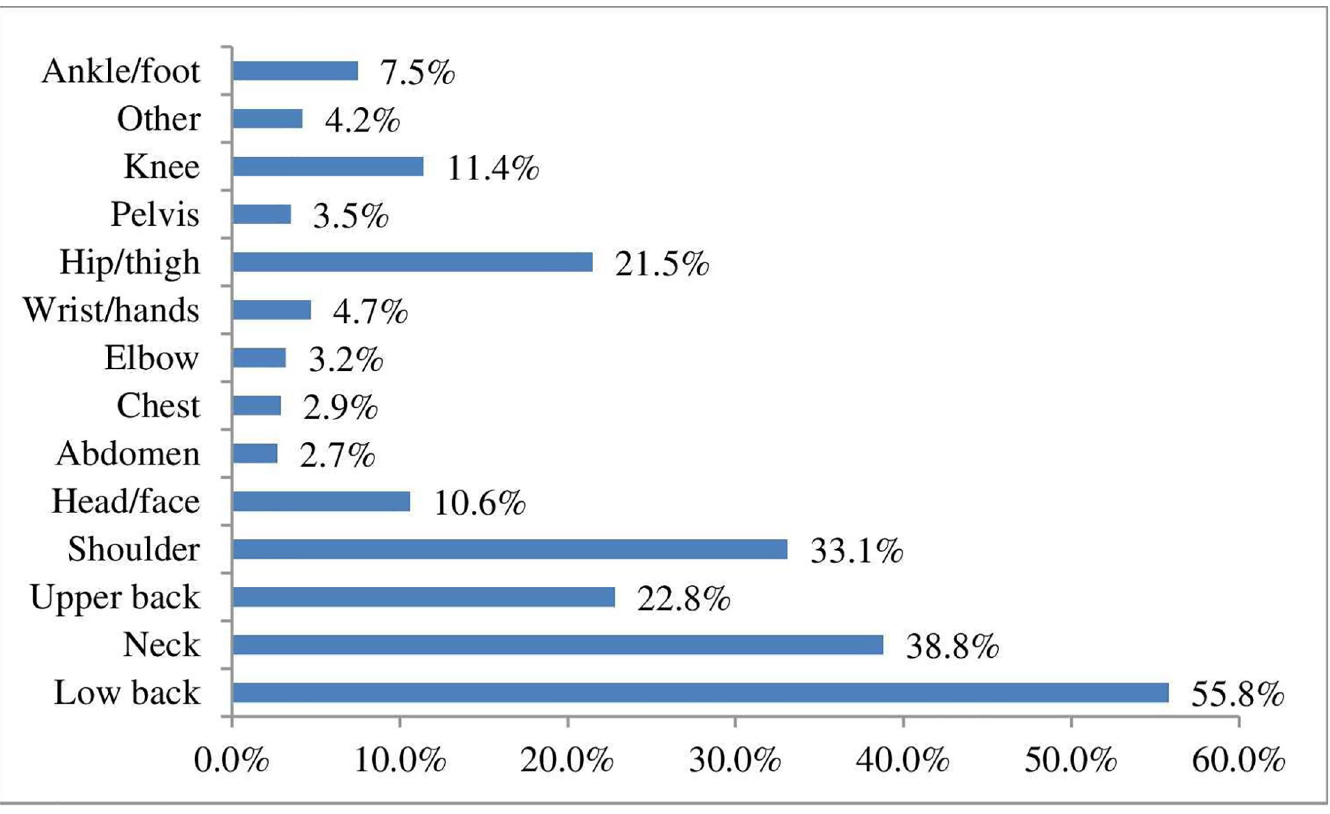
Fig 3. Symptom areas reported by patients at